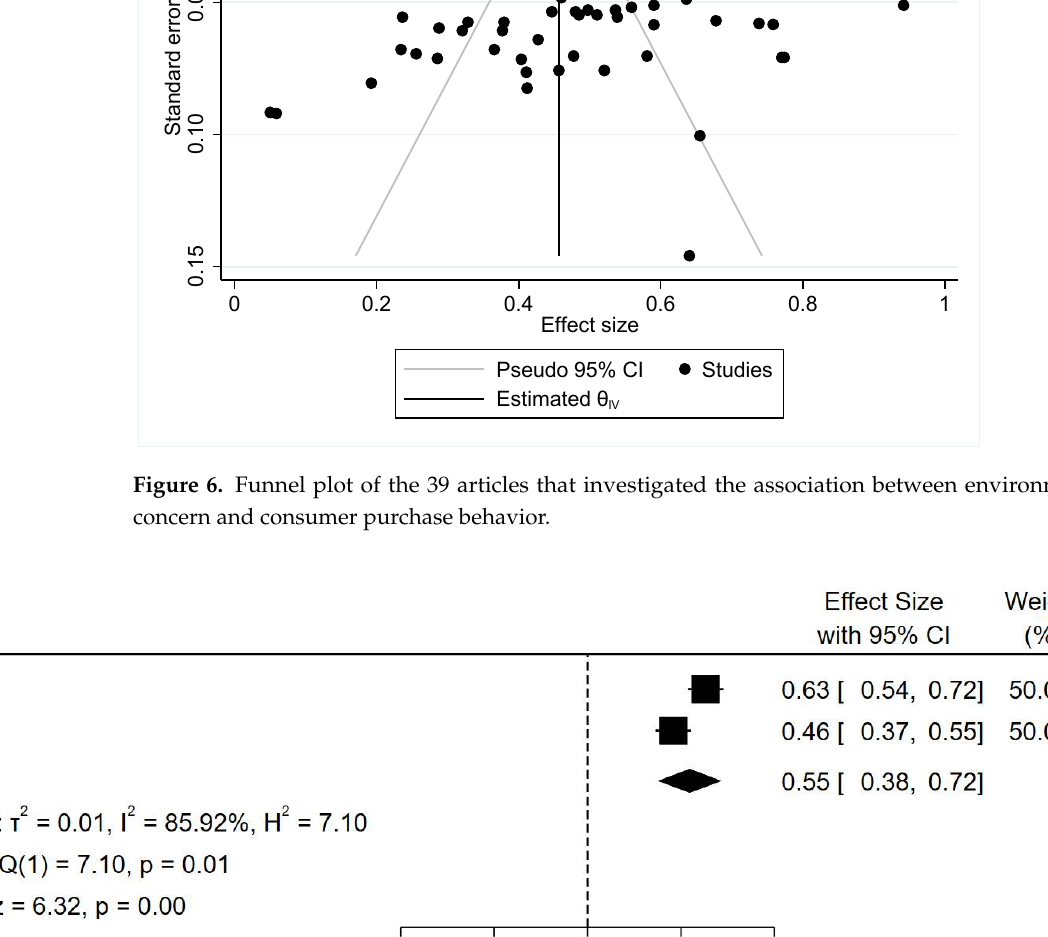
Figure 6. Funnel plot of the 39 articles that investigated the association between environmental con- cern and consumer purchase behavior.